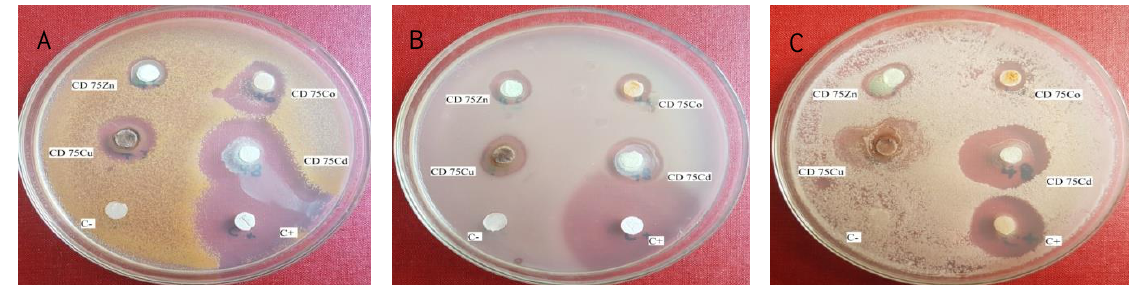
Figure 5. ( A ) The antibacterial activity for QBSC compounds 4a (CD 75Zn), 4b (CD 75Cu), 4c (CD 75Co) and 4d (CD 75Cd) against S. aureus (C+: positive control; C−: negative control). ( B ) The antibacterial activity for QBSC compounds 4a (CD 75Zn), 4b (CD 75Cu), 4c (CD 75Co) and 4d (CD 75Cd) against E. coli (C+: positive control; C−: negative control). ( C ) The antifungal activity for QBSC compounds 4a (CD 75Zn), 4b (CD 75Cu), 4c (CD 75Co) and 4d (CD 75Cd) against C. albicans (C+: positive control; C−: negative control).